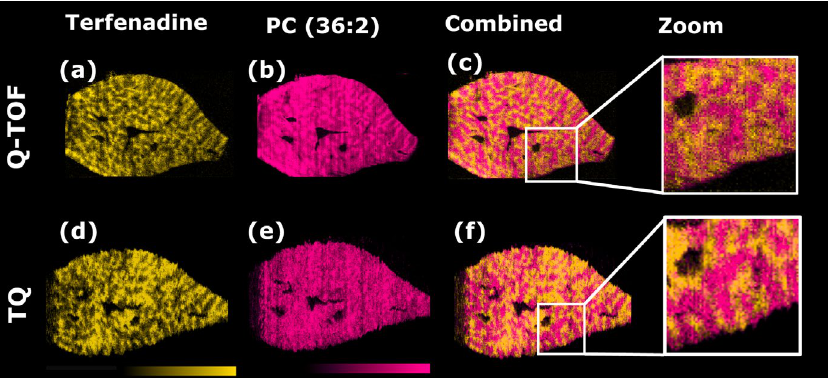
Figure 2. Ion images for terfenadine ( a , d ) and endogenous lipid PC(36:2) ( b , e ) obtained by DESI-MSI performed on a Xevo G2-XS or a Xevo TQ-S. ( c , f ) show the combined ion images of the drug and the endogenous lipid. The zoomed view displays the tissue edges. Images ( d – f ) were re-aligned as described in the Supplementary Information (Figure S1). The original, unprocessed images can be found in Figure S2.